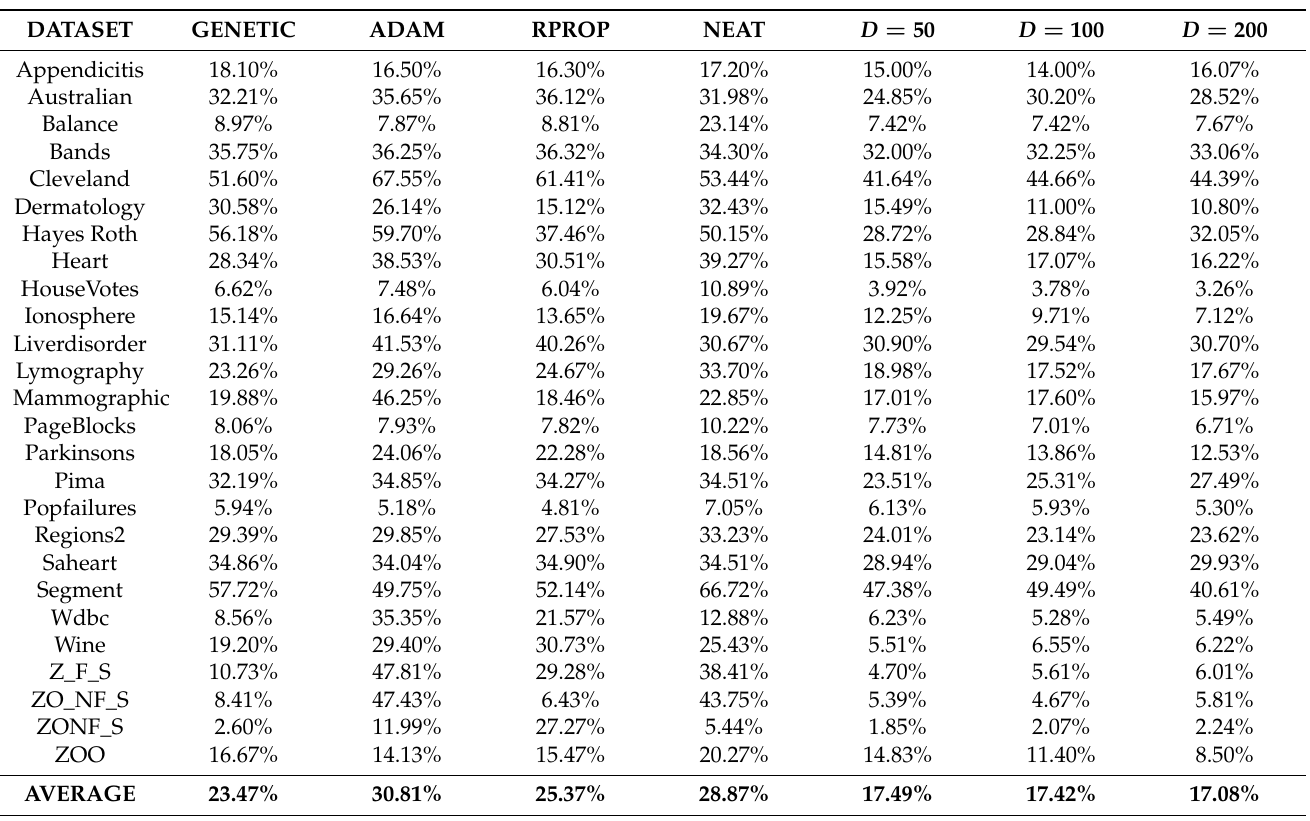
Table 2. Experiments for classification datasets.